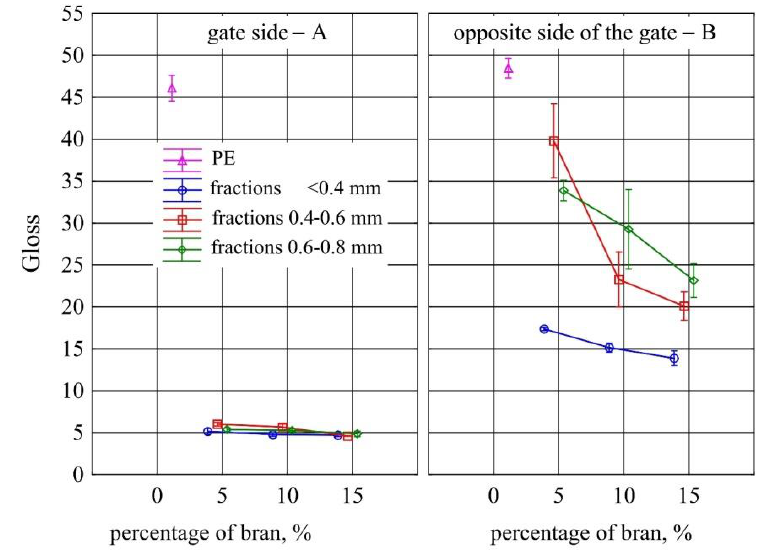
Figure 4. Variability of the color parameters L, a, b of injection mouldings depending on the content of the mass fraction of bran and grain size of 0.6–0.8 mm at measuring points A and B (location of measuring points marked in Figure 1).